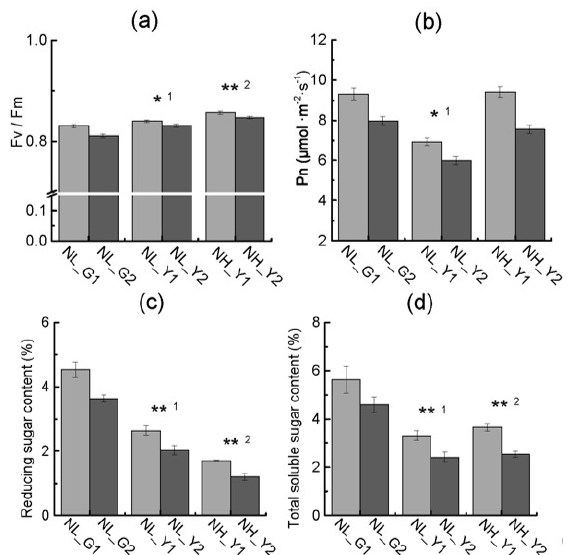
Figure 5. Differences in Fv/Fm ( a ), Pn ( b ), reducing sugar content ( c ), total soluble sugar content ( d ) in flue-cured tobacco and burley tobacco at the same nitrogen level and same leaf biomass accumulation condition. Fv/Fm: Maximum quantum yield of PS II photochemistry; Pn: Photosynthetic rate. NL_G1: low nitrogen level, HD; NL_G2: low nitrogen level, Z100; NL_Y1: low nitrogen level, TN90; NL_Y2: low nitrogen level, TN86; NH_Y1: high nitrogen level, TN90; NH_Y2: high nitrogen level, TN86. Error bars of chlorophyll a fluorescence and photosynthesis rate indicate standard error of the means (N = 20, “N” means the number of individuals), and error bars of reducing sugar content and total soluble sugar content indicate standard error of the means ( n = 3, three biological replicates). Symbols ** 1 and * 1 indicate that the significant differences between flue-cured tobacco and burley tobacco at the same nitrogen application are at 0.01 and 0.05, respectively. Symbols ** 2 indicate that the significant differences between flue-cured tobacco and burley tobacco at the same leaf biomass accumulation condition are at 0.01,